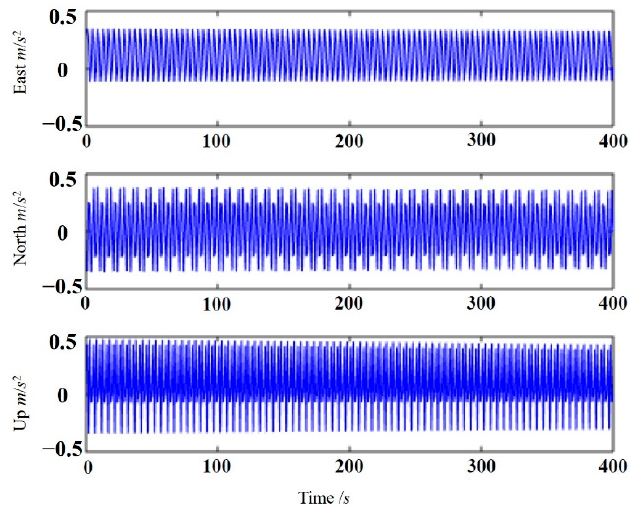
Figure 12. Acceleration of rod arm effect.